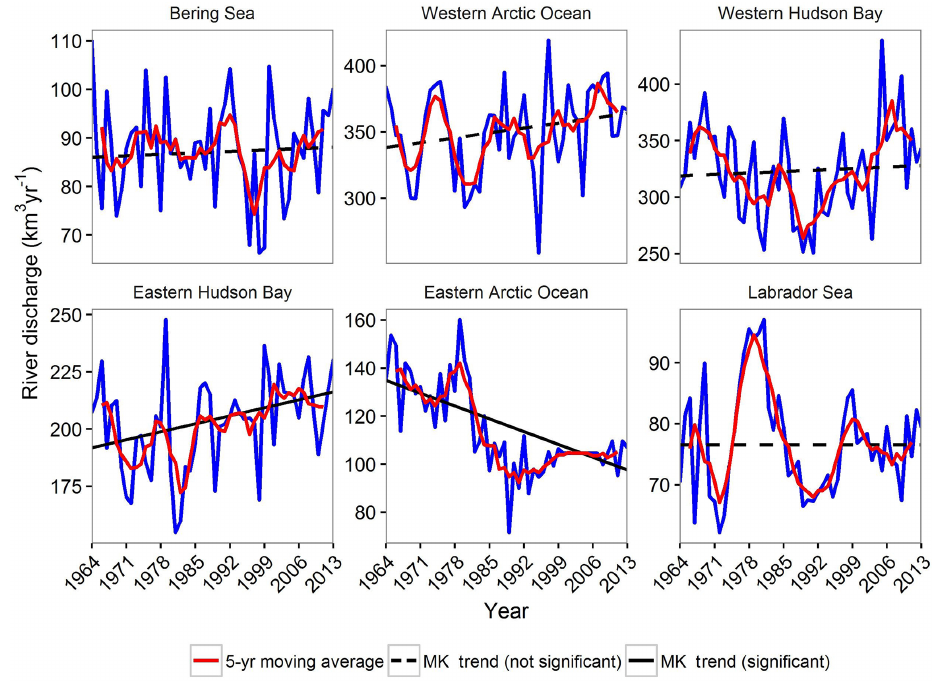
Figure 2. Time series of total annual discharge for six major drainage basins of northern Canada,